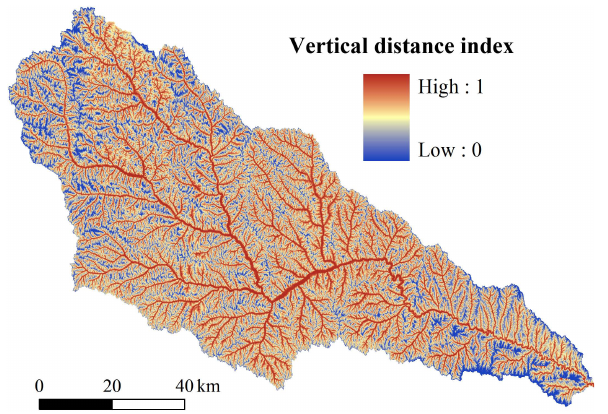
Fig. 4. Spatial distribution of the soil loss horizontal distance index values in the Yanhe watershed.